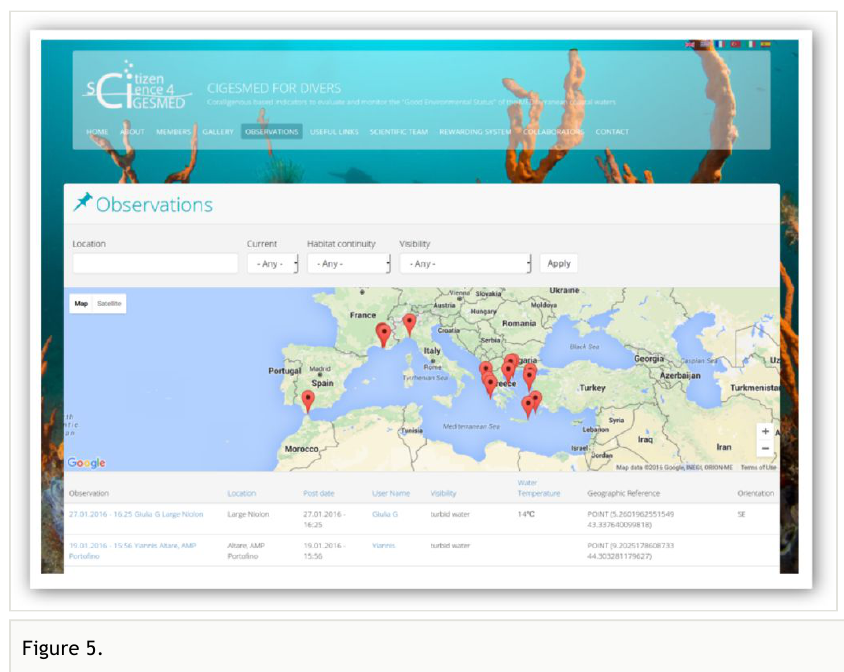
Figure 5. Accumulative map of uploaded observations for Mediterranean coralligenous assemblages on the CIGESMED for divers